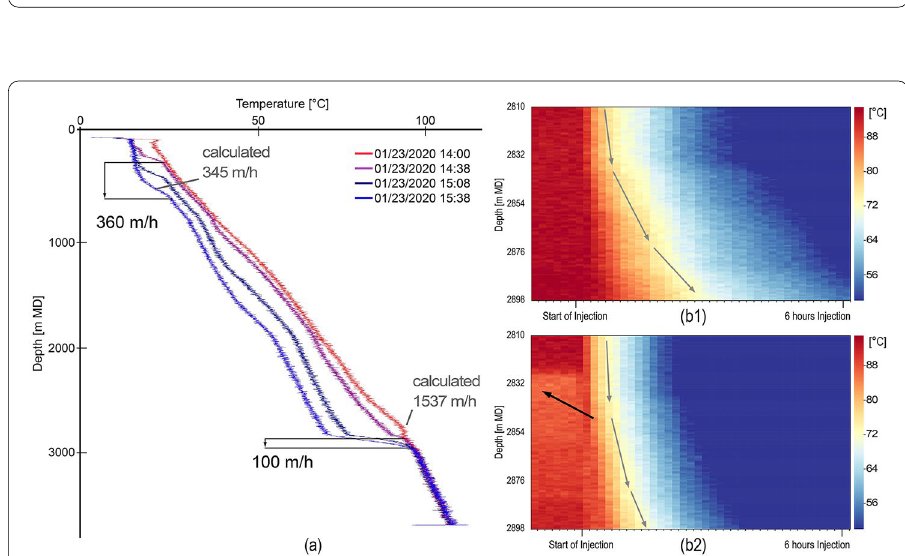
Fig. 9 Analysis of velocity of the injected cold water. a Vertical movement of cold waterfront of Inj1. b1 Heat plot of Inj1. b2 Heat plot of Inj2. Gray arrows: suggested 75 °C isotherm. The black arrow marks the